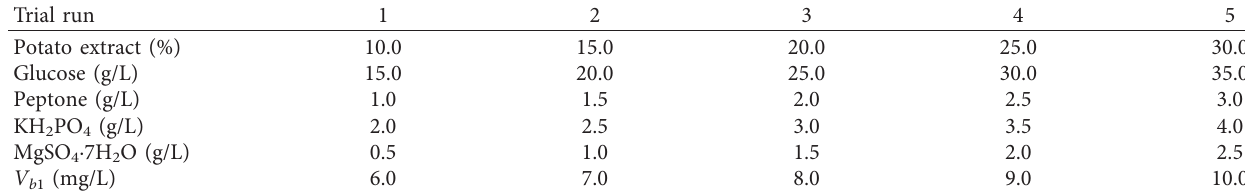
Table 1: Design of the single-factor experiment for a basic culture medium.